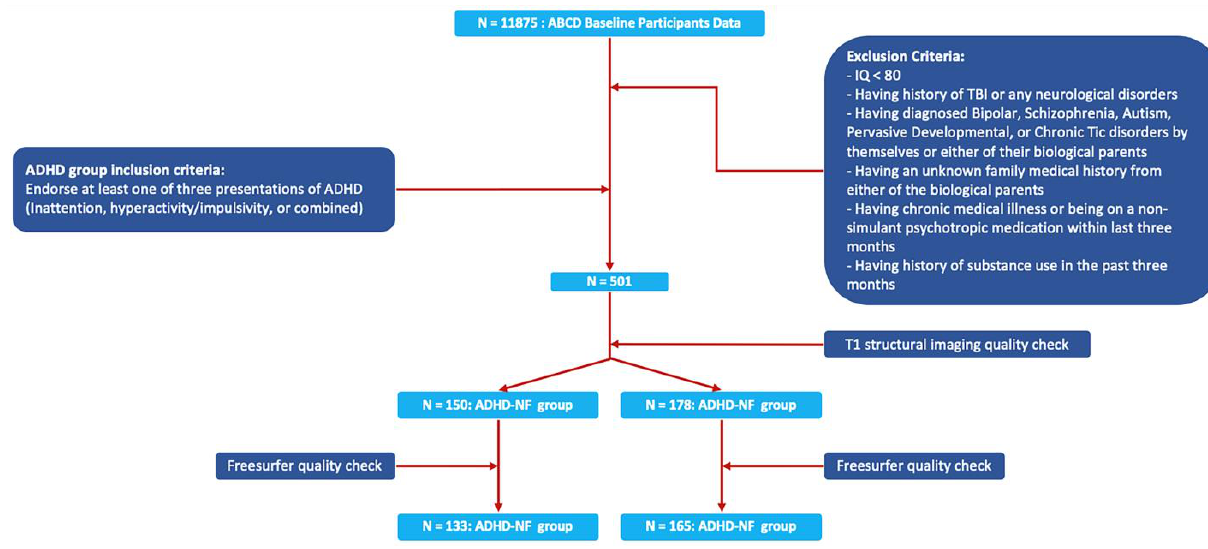
Figure 1. ADHD participants’ inclusion and exclusion flowchart.